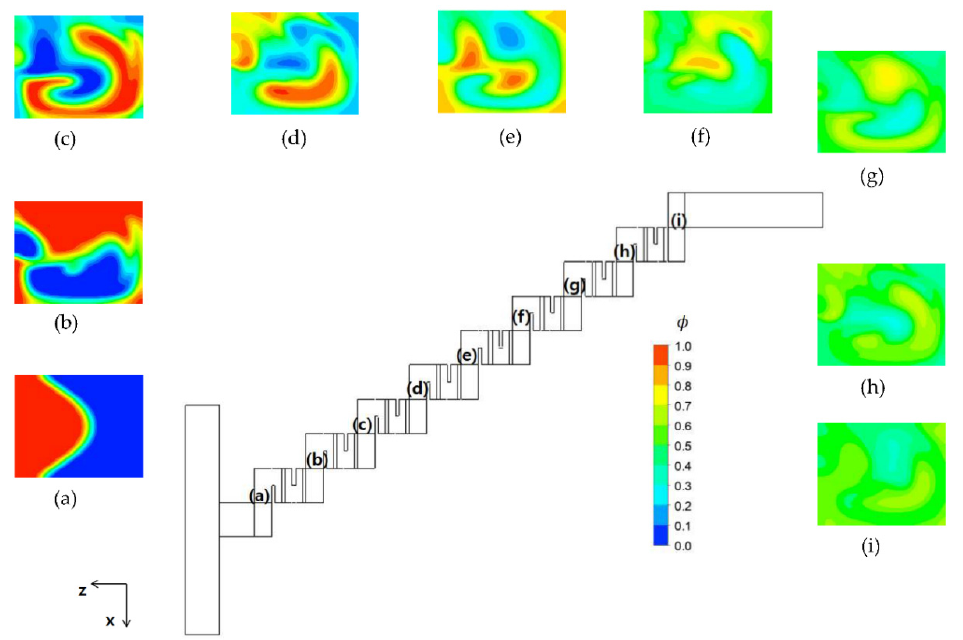
Figure 10. Concentration distribution at the cross section before and after the mixing unit for Re = 20.